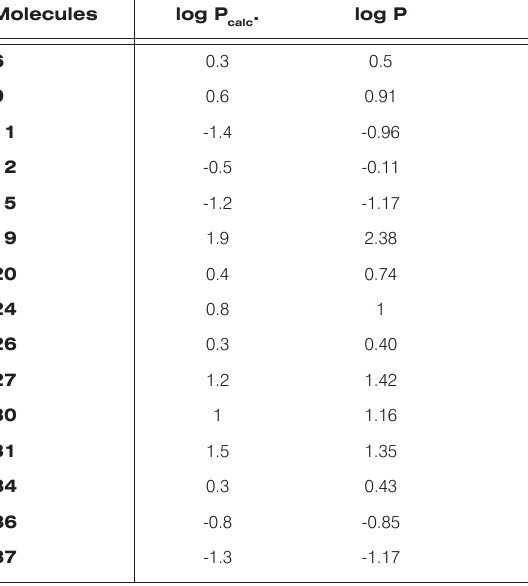
molecules in the test set. Molecules log P . calc